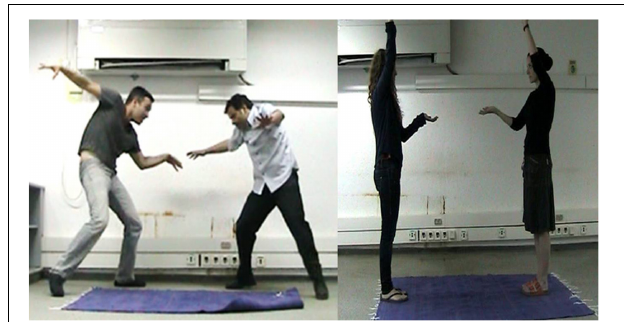
FIGURE 1 | Examples of the MG: each participant played with a research assistant of the same gender. Note: all participants shown in this figure provided written informed consent for the publication of this